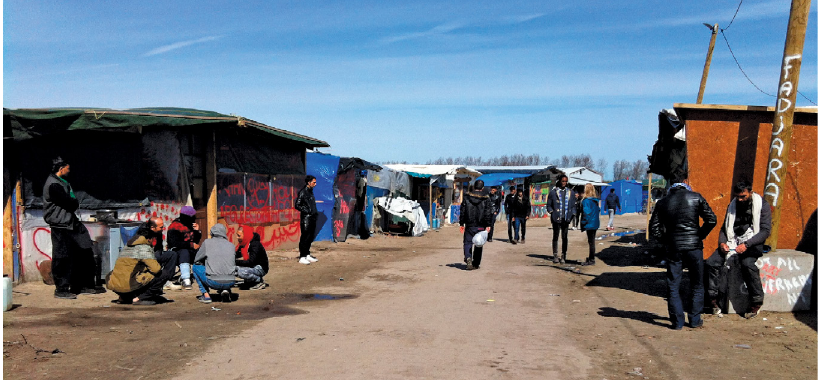
Figure 2. The “high street” of the ‘Jungle’, Calais, France, April 2016. Photo by Author.